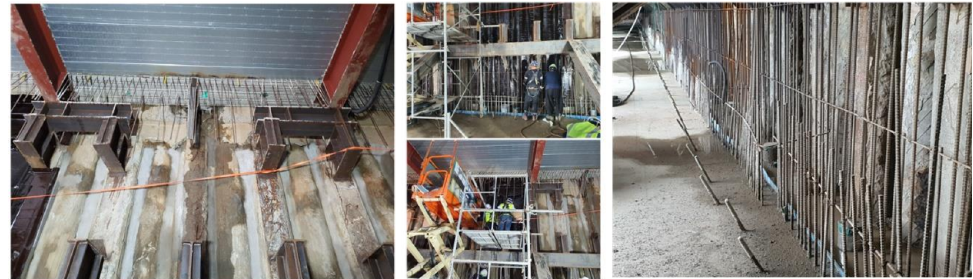
Figure 2. Examples of on-site waterproofing of pile walls (Dae-gu City,